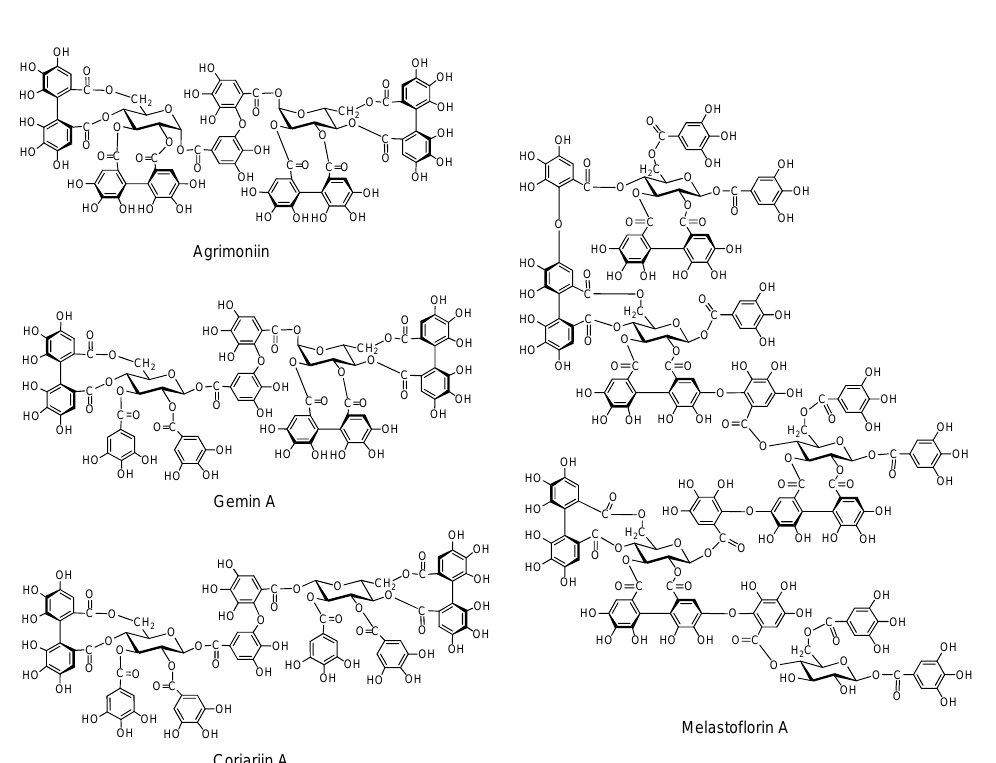
Figure 6. Ellagitannin